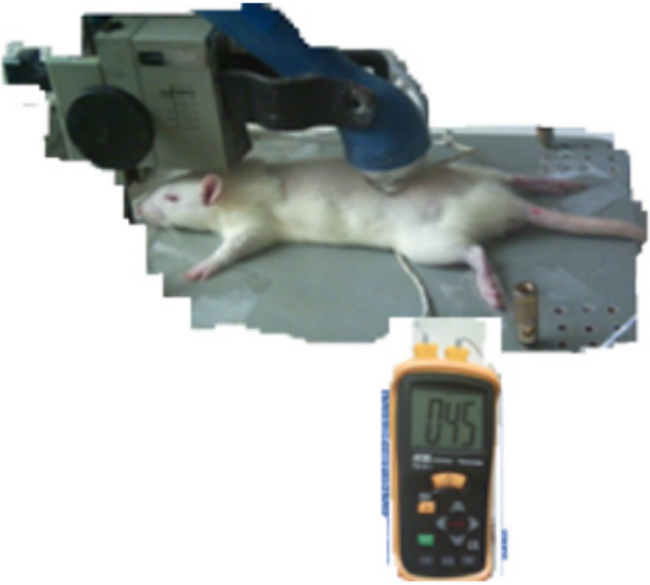
FIGURE 1 – Experimental setup: position of animal, US equipment and digital thermometer with display of tumor